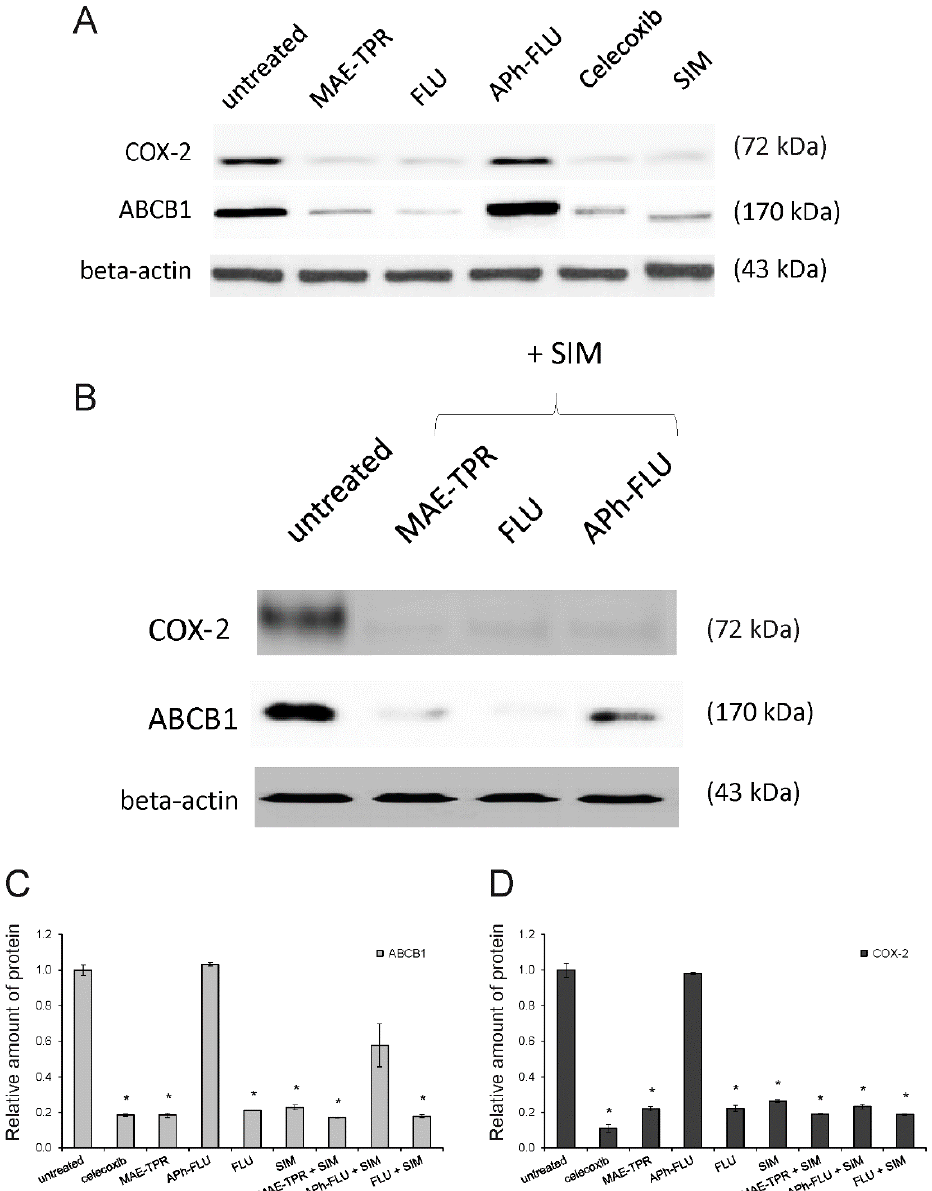
Figure 4. Analysis of cyclooxygenase-2 (COX-2) (dark grey bars) and ABCB1 proteins (light grey bars) expression in LoVo/Dx cells treated with phenothiazine derivatives and simvastatin (SIM) as single agents ( A ) and phenothiazine derivatives in combination with simvastatin ( B ) for 48 h. The molecular masses of the proteins are indicated at the right side of the gel. β -actin was used as a reference protein. Celecoxib (selective COX-2 inhibitor) was used as a control. The relative level of ABCB1 ( C ) and COX-2 expression ( D ) normalized to the control derived from non-treated LoVo/Dx cells. The results of three experiments ± SD are presented. The statistically significant differences from the untreated controls were determined using Student’s t -test (* p < 0.05).